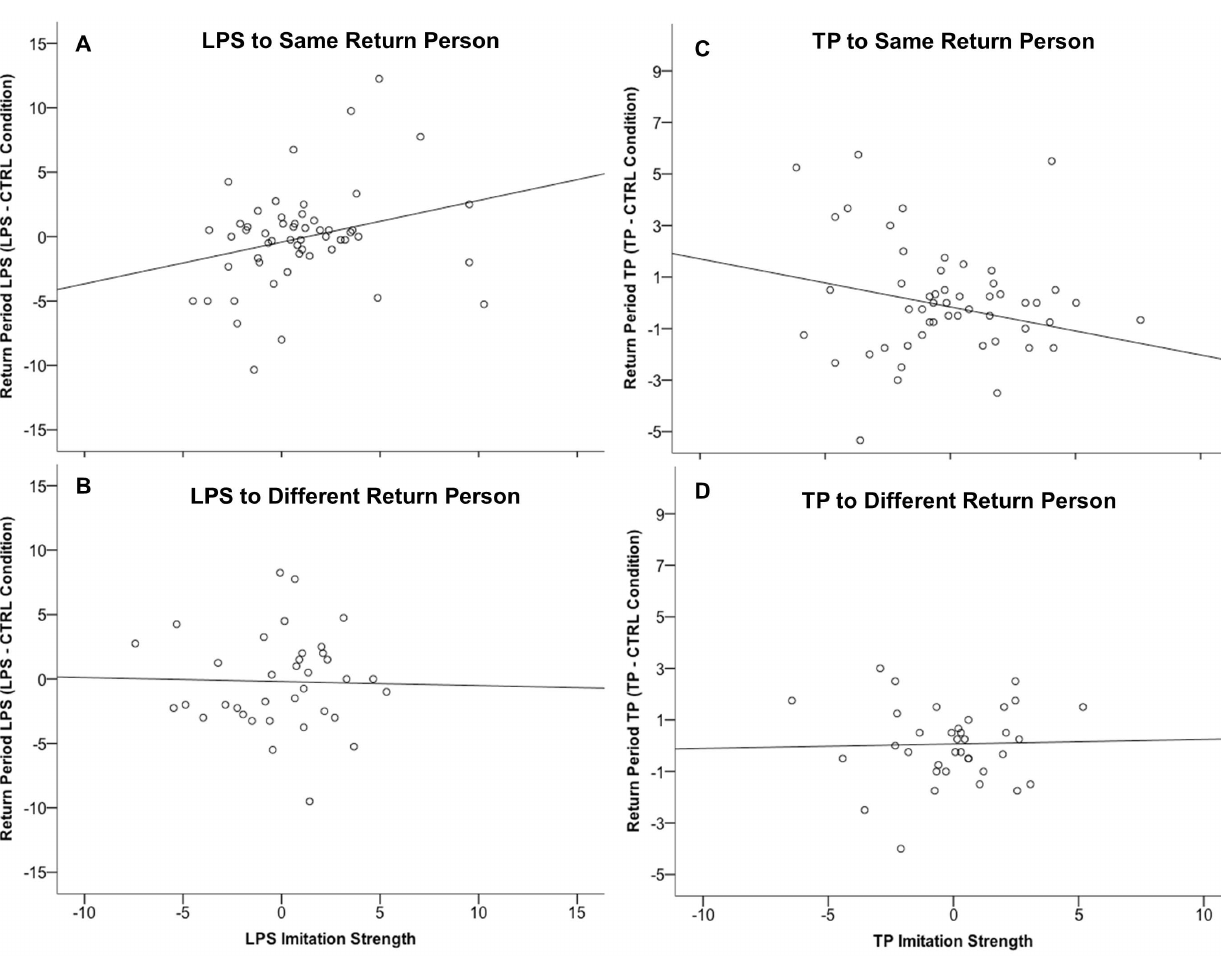
Figure 2. Scatterplots of the relationship between imitation strength and gesture rates during the Return period. Imitation strength is reported separately for lipsmacking (LPS; plots A and B) and for tongue protrusion (TP; plots C and D), and was calculated using the LPS and TP Imitation Index (see main text). Higher scores indicate stronger imitation. Only for LPS was there a stronger correlation when the return person was the same (A) compared to when the return person was different (B), p , .001; for TP there was no difference in the correlation coefficients when the return person was the same (C) or different (D), p =.17.